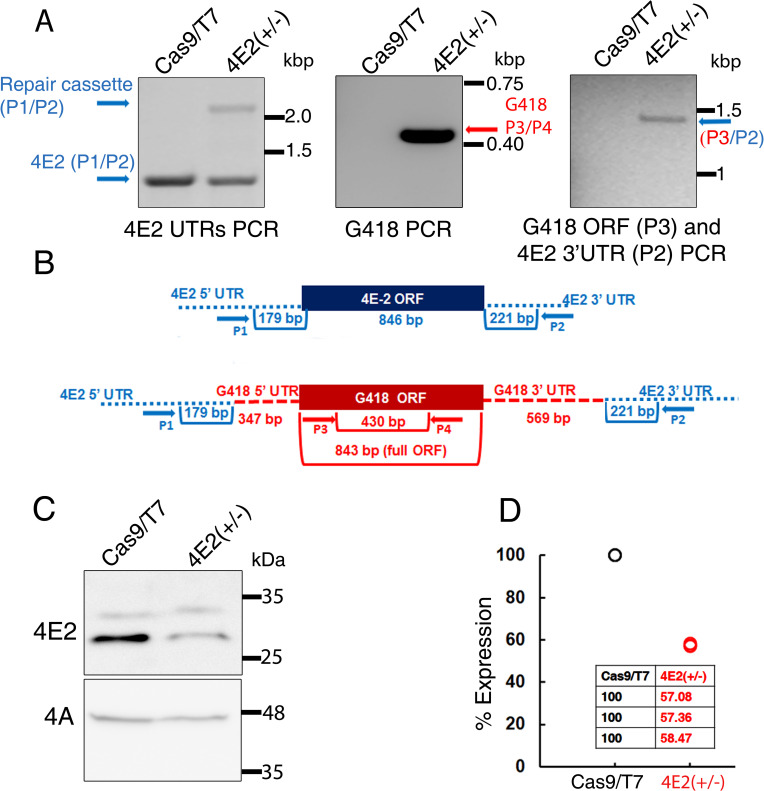
CRISPR-Cas9 mediated hemizygous deletion of LeishIF4E2.(A) Diagnostic PCR was performed to confirm the deletion of single allele of LeishIF4E2. Genomic DNA was extracted from L. mexicana Cas9/T7 cells and from the LeishIF4E2(+/-) mutant. PCR was performed using different combinations of primers derived from the LeishIF4E2 5’ UTR (Forward) and 3’ UTR (Reverse) (P1/P2 –left panel); G418 ORF (Forward) and Reverse (P3/P4, middle panel); and a primer set derived from the G418 resistance gene, forward and the 3’ UTR (Reverse) (P3/P2). (B) Schematic representation of LeishIF4E2 locus and primers (represented by arrows). The PCR was applied to test the presence or absence of the LeishIF4E2 gene and the G418 resistance marker. Primers derived from the LeishIF4E2 UTRs are shown in blue and primers derived from the ORF of G418 are shown in red. (C) Western analysis monitoring the protein level of LeishIF4E2 in the LeishIF4E2(+/-) mutant and in Cas9/T7 control was performed using LeishIF4E2 specific antibodies. LeishIF4A-1 served as a loading control. (D) Dot plot representing the densitometry analysis of the LeishIF4E2 protein levels in the LeishIF4E2(+/-) mutant and in the Cas9/T7 controls.